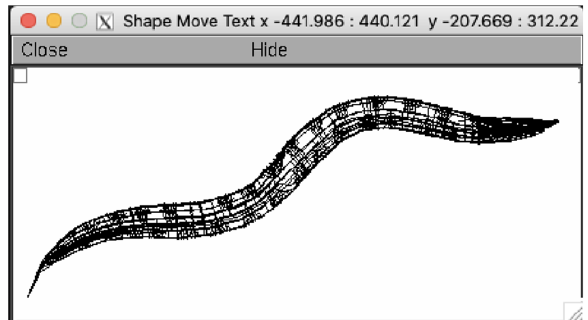
Figure 1. The C. elegans connectome described in